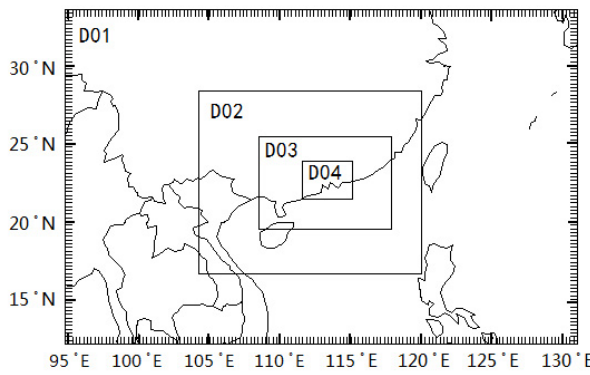
Fig. 4. Domain settings in WRF model.